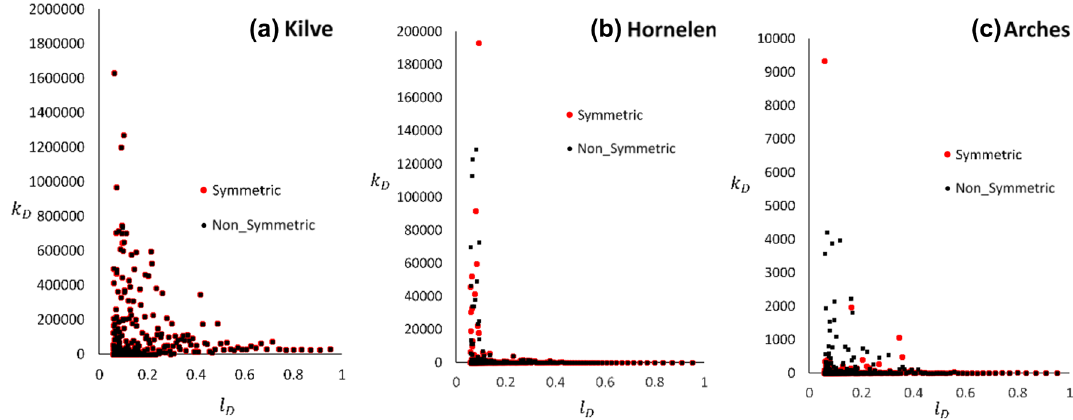
Fig. 9 REV analysis of Kilve ( a ), Hornelen ( b ), and Arches ( c ) for both symmetric and non-symmetric conditions, where dimensionless permea- = k max k bility is displayed versus dimensionless sample size D k matrix